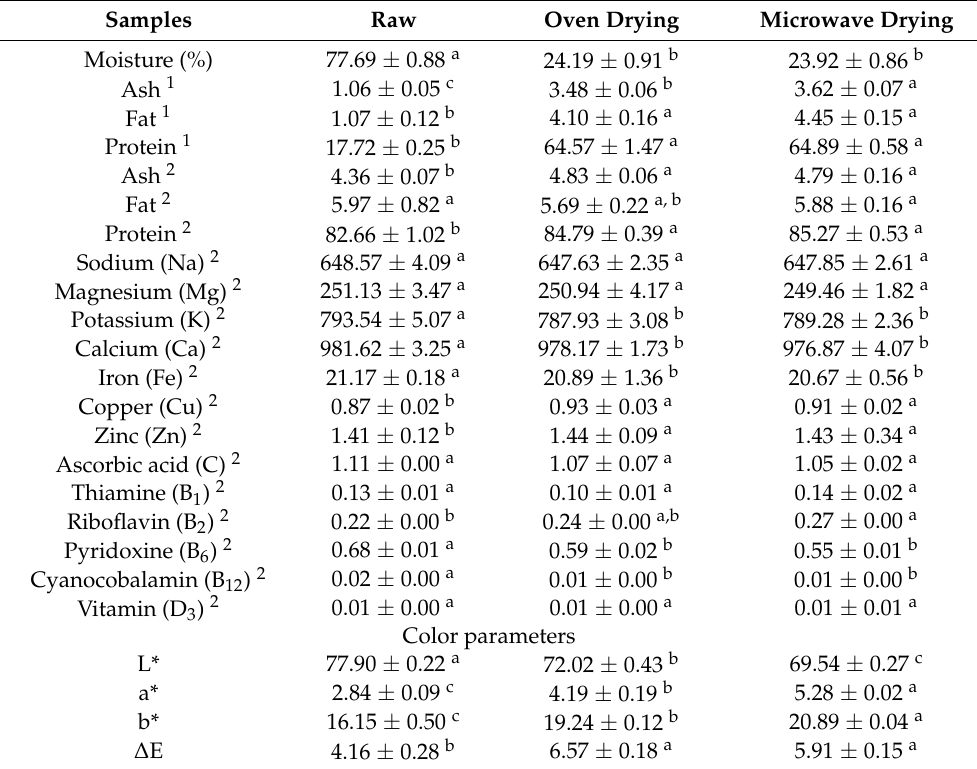
Table 1. Chemical composition and color parameters (mean ± SD) of raw, oven, and microwave drying of bighead carp H. nobilis fillets.